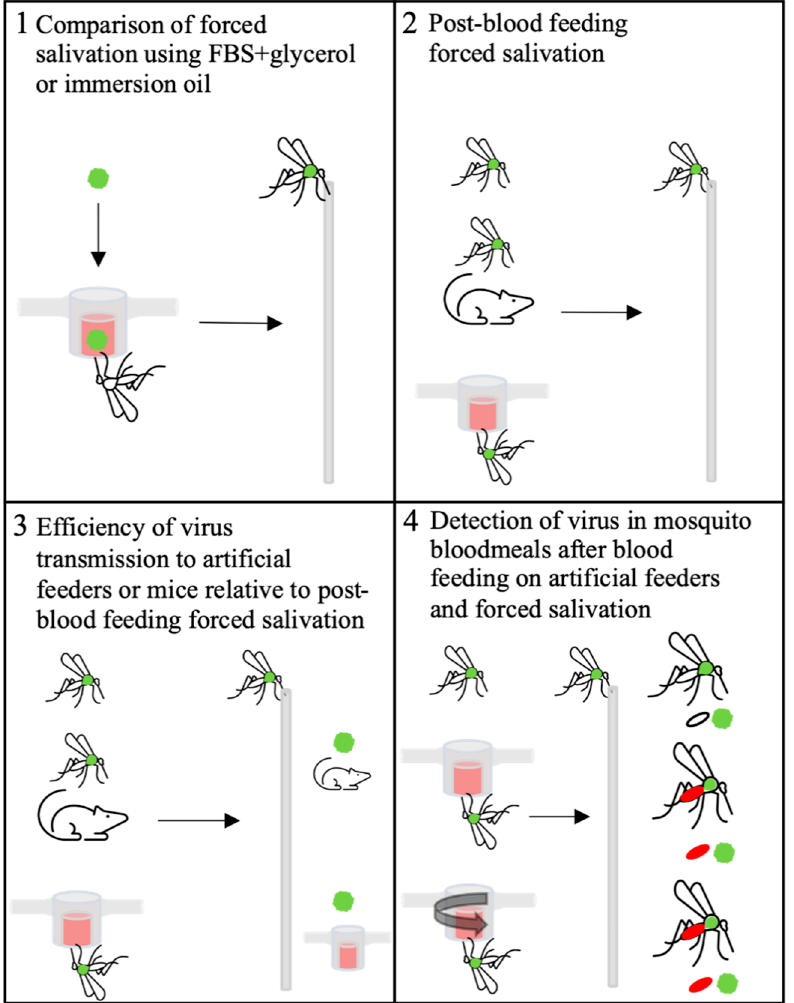
Figure 1. Graphical picture of experiments completed in this study. Green ball represents Zika virus (ZIKV) or chikungunya virus (CHIKV). Green thorax mosquitoes = mosquitoes infected by infectious bloodmeal as shown in panel 1.